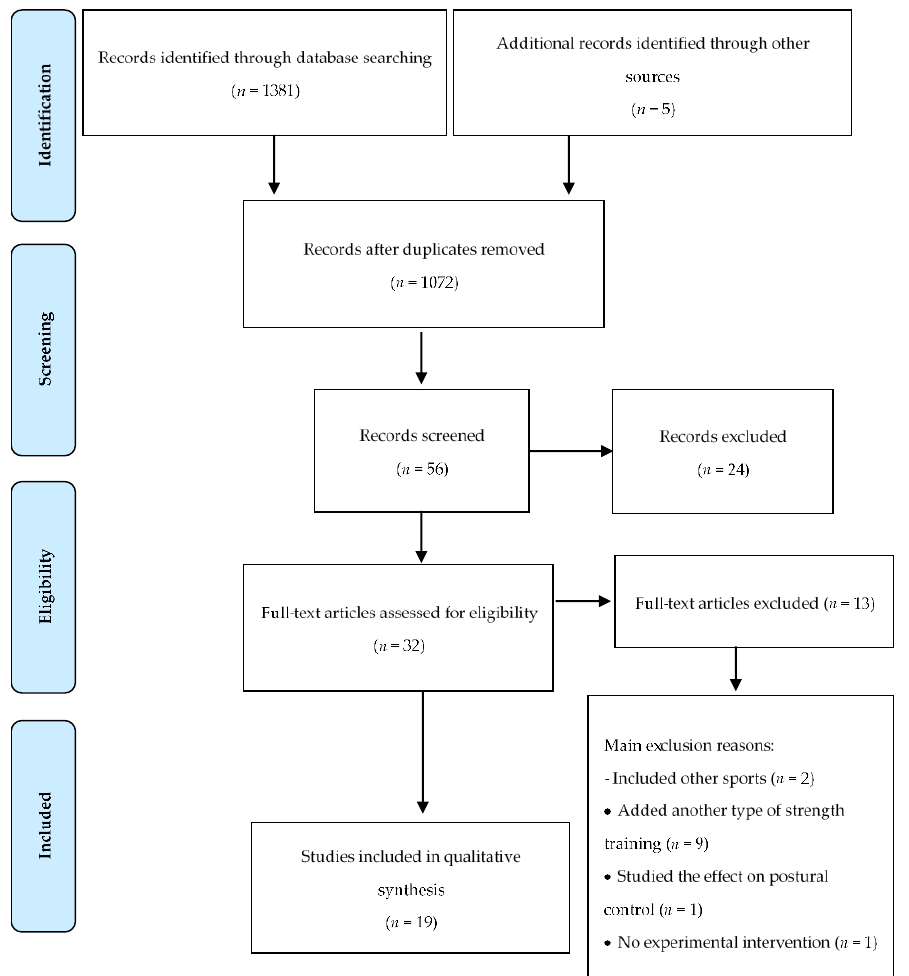
Figure 1. Flowchart on the literature search of plyometric training in volleyball.